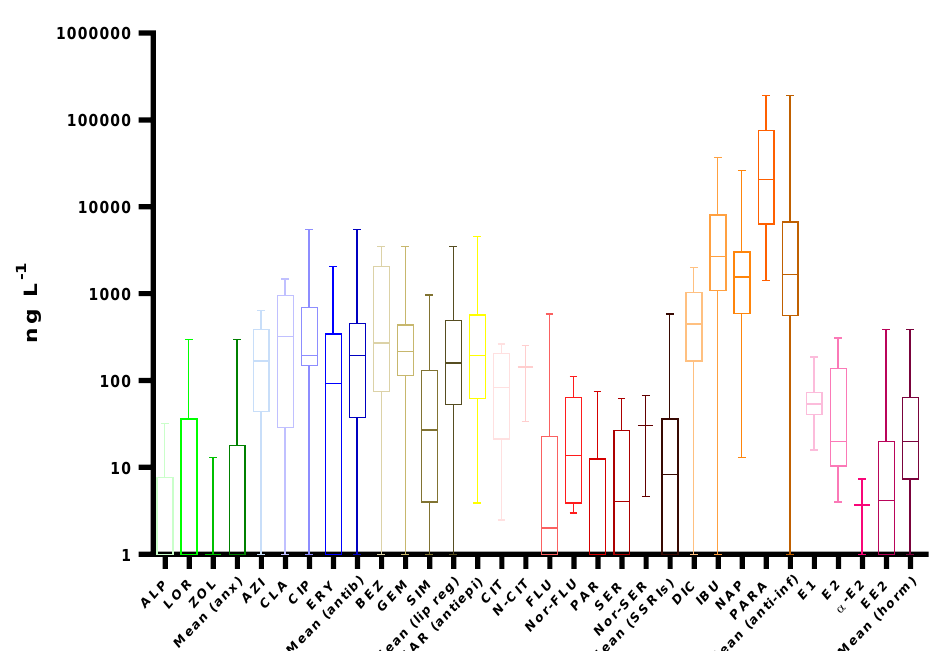
Figure 2. Boxplots with median, maximum and minimum average concentrations of pharmaceuticals in wastewater influents (WWIs). Anx — anxiolytics, Antib — antibiotics, Lip reg — lipid regulators, Antiepi—antiepileptics, SRRIs—selective serotonin uptake inhibitors, Antiepi — antiepileptics, SRRIs — selective serotonin uptake inhibitors, Anti-inf — anti-inflammatories